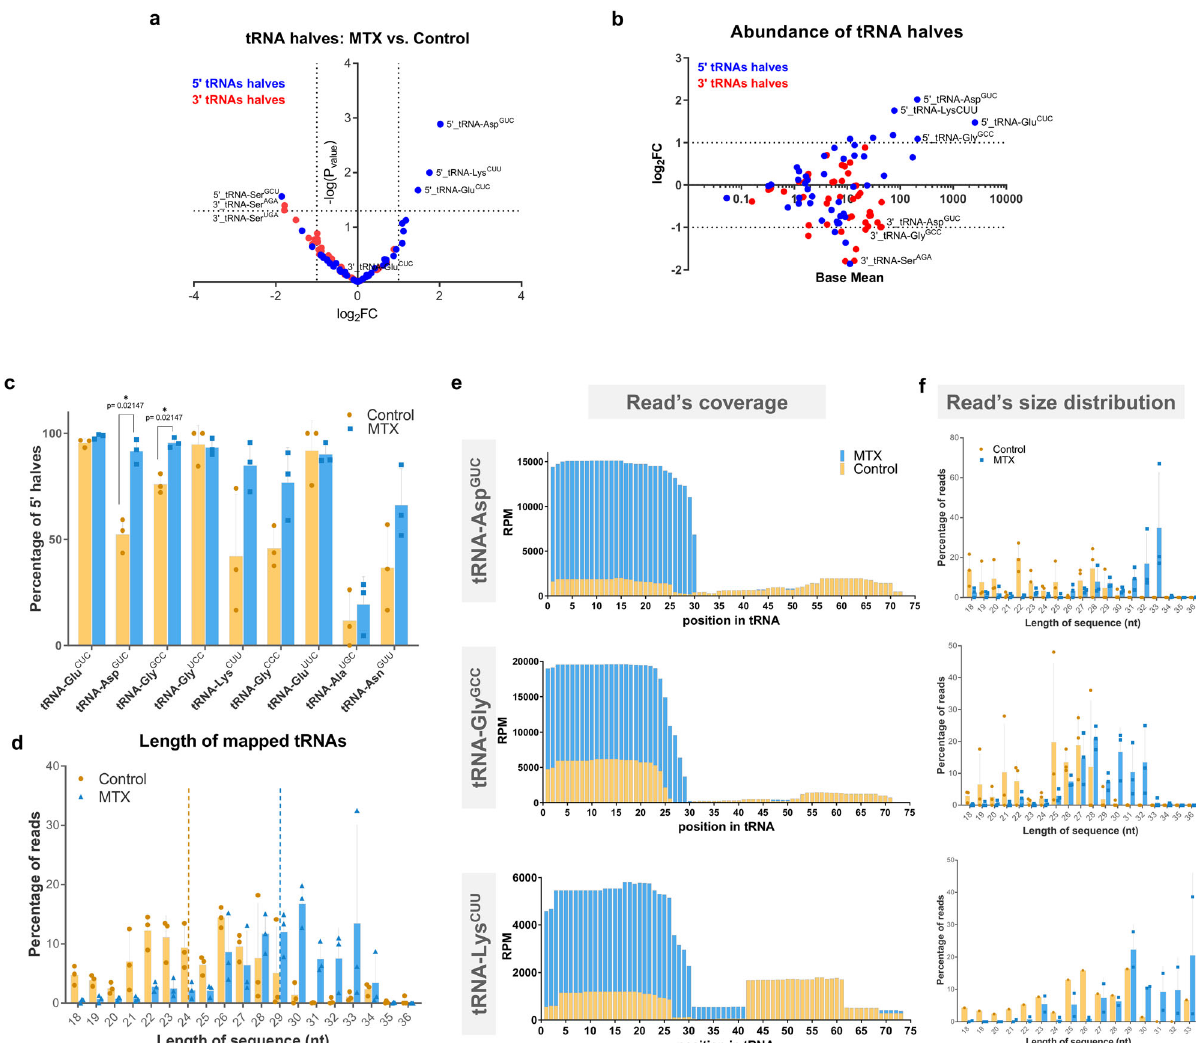
Fig. 4 | PaternalMTX injectioninducedthe expression and cleavage ofspeci fi c tRNAs.a Volcanoplotof depicting thefold changesinsperm5 ′ and3 ′ tRNAhalves asbeingdifferentiallyexpressedwithincontrolversusMTXtreatedmales.Analysis ofdifferentialexpressionwasperformedbyusingDESeq2whichusethetwo-tailed Wald test. b MAplotdisplaying normalized counts (basemean)fordifferent5 ′ and 3 ′ tRNAhalves. Dotted lines depict thresholdsvaluesfor signi fi cantlyup and down- regulated (± ≥ 1 log 2 fold change and -log 10 Pvalue ≥ 1.3). See also Supplementary Data 3 for a and b . c Histogram displaying percentage of 5 ′ halves relative to their corresponding 3 ′ halves from different tRNAs affected by MTXtreatment. Asterisk